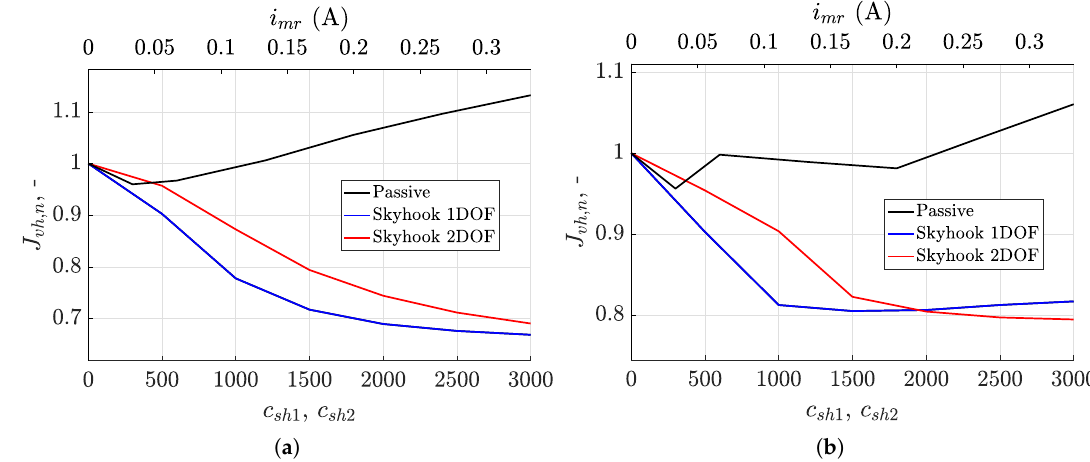
Figure 20. Comparison of vehicle handling for different suspension settings: passive, separate and coupled Skyhook control: ( a ) vehicle longitudinal velocity of 5 ms − 1 , ( b ) vehicle longitudinal velocity of 10 ms − 1